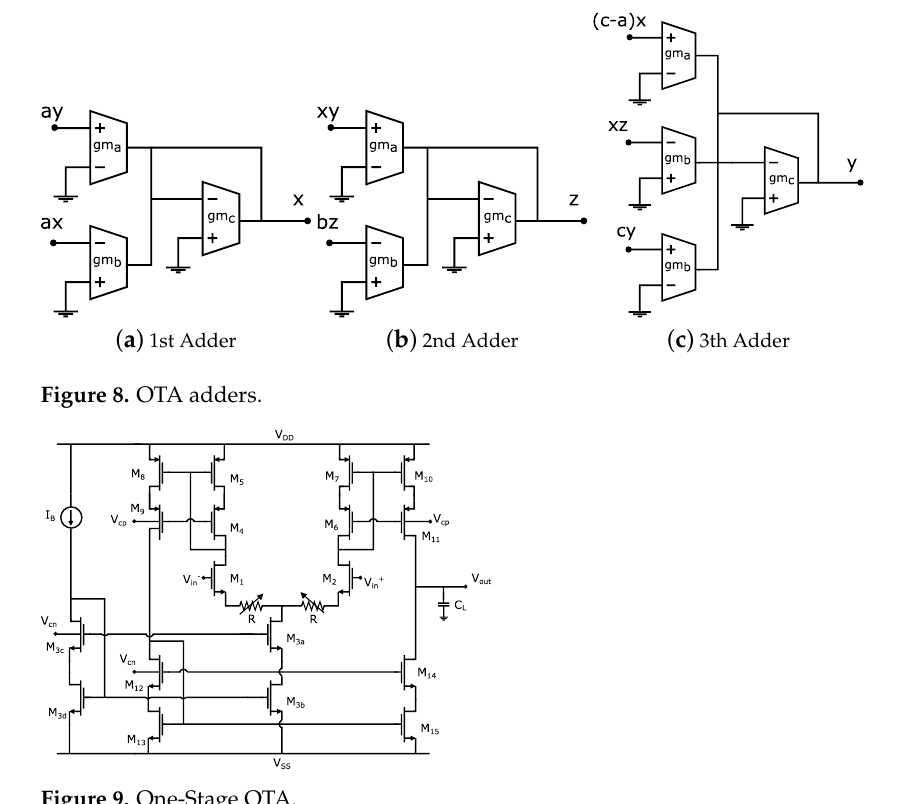
Figure 9. One-Stage OTA. Table 5. Electrical characteristics and feasible W/L sizes of the OTA shown in Figure